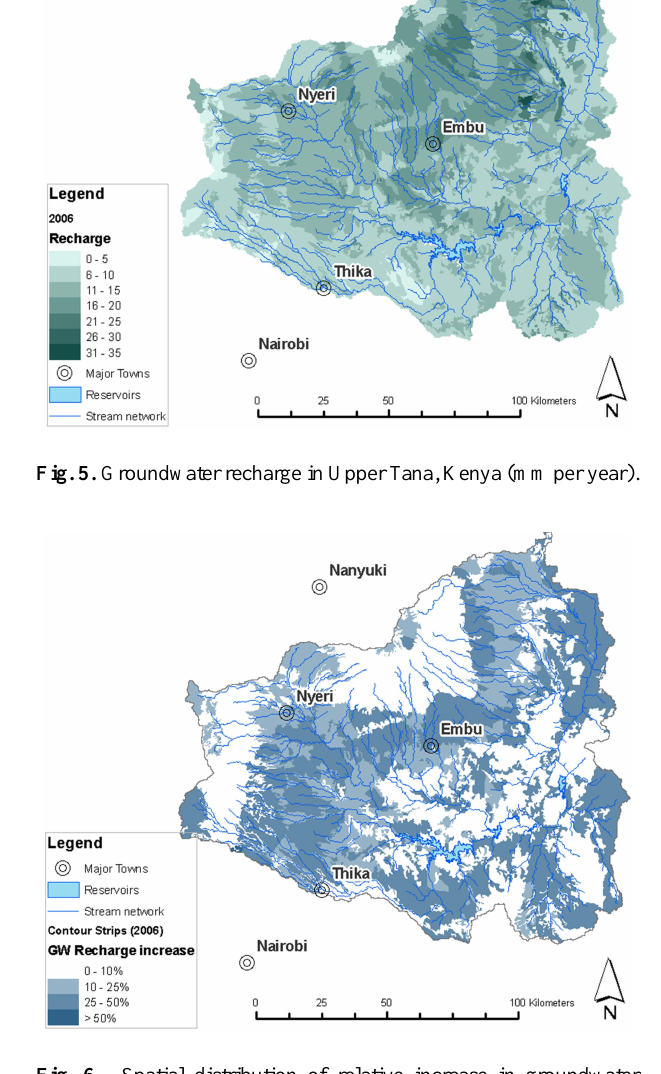
Fig. 6. Spatial distribution of relative increase in groundwater recharge for the contour strips scenario in Upper Tana,